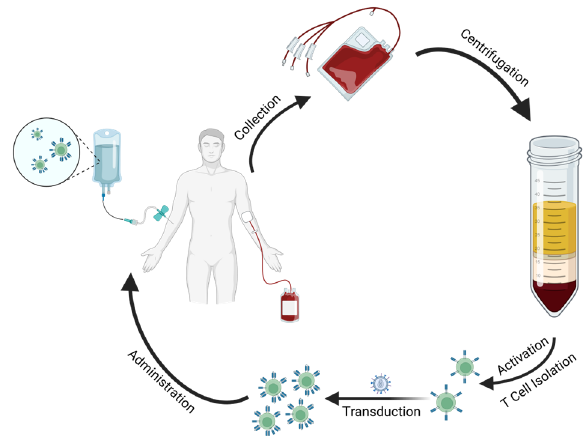
Figure 3. Simpli fi ed visualization of the steps involved in an example manufacturing process for Figure 3. Simplified visualization of the steps involved in an example manufacturing process for CAR T cells. CAR T